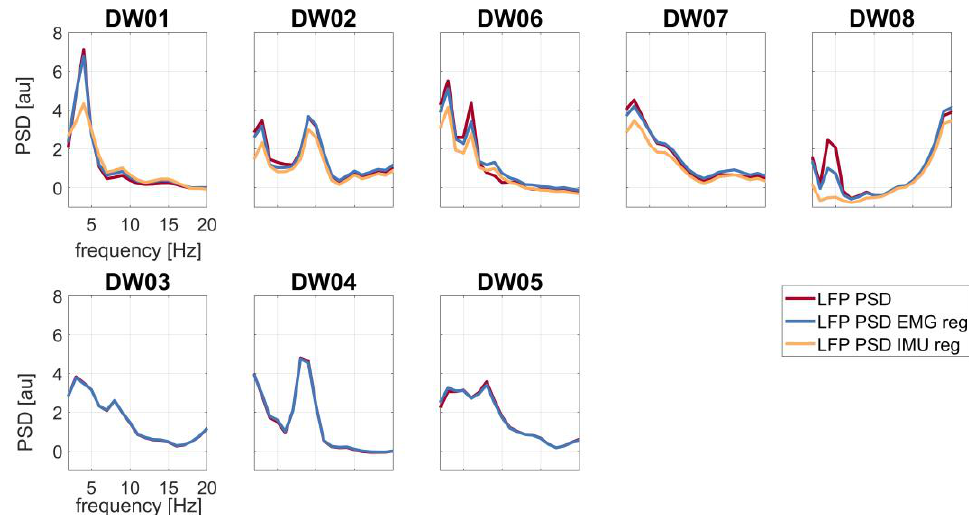
Figure 3. LFP spectral profiles before regression (red line), after EMG regression (blue line), and after IMU regression (yellow line). First row: patients with tremor (T+); second row: patients without tremor (T − ). Abbreviation: reg (regression). Table 2. Columns 2 – 4: theta-alpha peak power [au] without and with EMG or IMU regression. Differences ( Δ ) between LFP theta-alpha peak power without and with EMG or IMU regression are shown in brackets. Columns 5 – 6: averaged theta-alpha pallido-muscular COH without and with IMU regression. The differences ( Δ ) between LFP and EMG COH without and with IMU regression are shown in brackets. Abbreviations: COH — coherence; EMG — electromyographic recording; IMU — inertial measurement unit recording; LFP — local field potential; reg — regression; NA — not available.